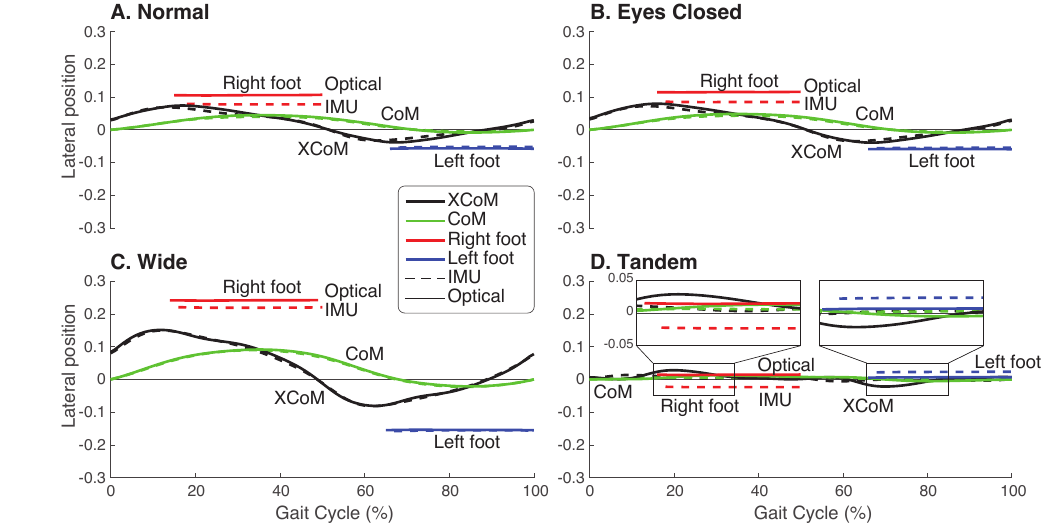
Figure 2. Mediolateral trajectories over a gait cycle for both IMU and Optical. Mean ML XCoM (black), CoM (green), and right (red) and left (blue) BoS for each walking condition of ( A ) Normal, ( B ) Eyes Closed, ( C ) Wide, and ( D ) Tandem, as measured by the IMU (dashed) and Optical (solid) motion-capture systems ( N = 10). The BoS was determined from lateral foot positions. Positive values indicate the right direction, and negative values indicate the left direction. The gait cycle is shown as a percentage of stride from right heel strike to right heel